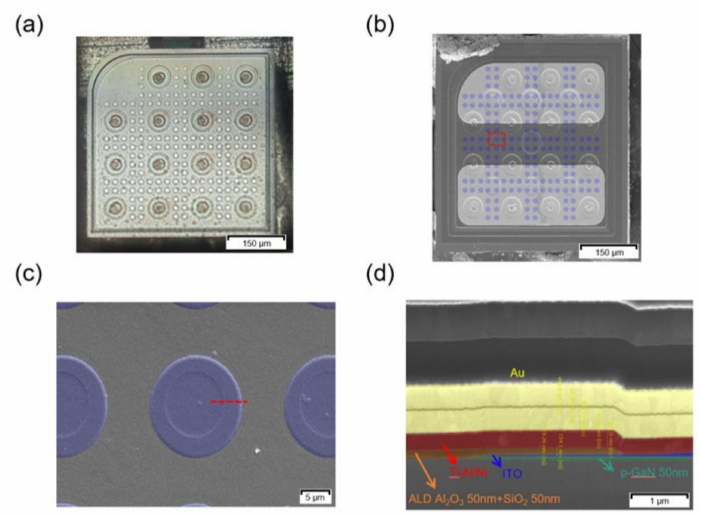
Figure 2. The OM and SEM images of the mesh p-GaN / ITO DUV LED. ( a ) OM image taken from the substrate side ( b ) SEM image taken from the p-side. ( c ) Enlarge SEM image of mesh p contact ( d ) Cross-sectional image of mesh p